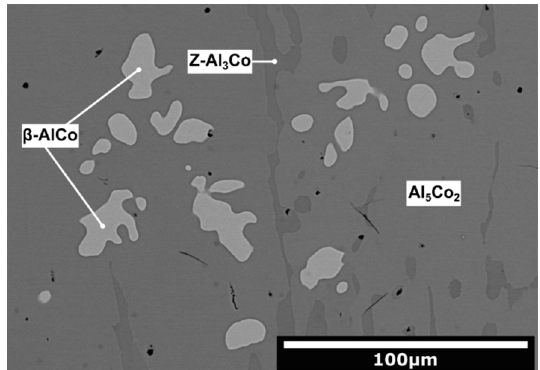
Figure 2. Microstructure of the as-solidified Al 71 Co 29 alloy.